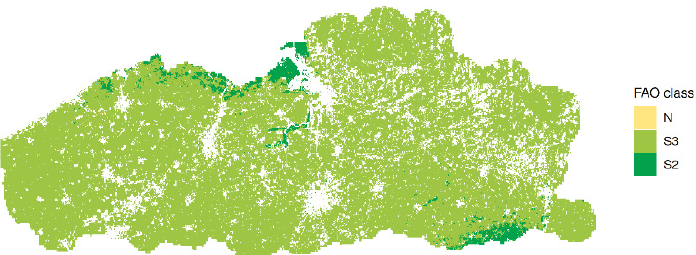
Figure 4. LS classes for maize in Flanders.